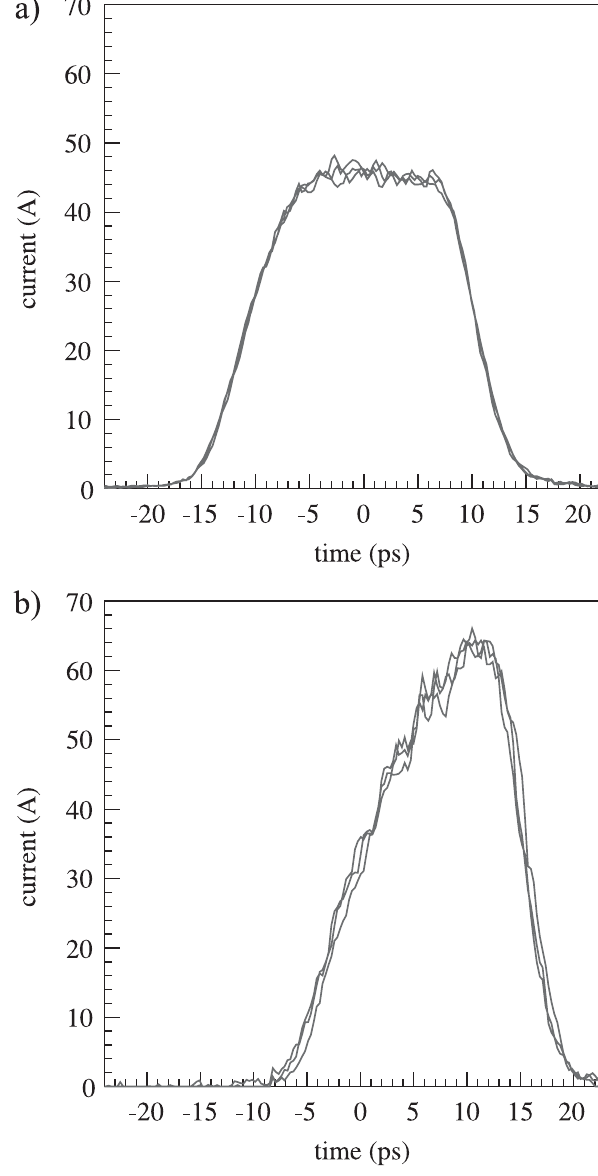
FIG. 27. Current profile measurements taken for gun and booster phase with (a) maximum energy gain and (b) booster phase 60 degrees off crest (three consecutive measurements). The bunch charge is 1 nC and the laser beam had a flattop distribution in longitudinal (FWHM about 20 ps) and transverse direction (diameter about 1.5